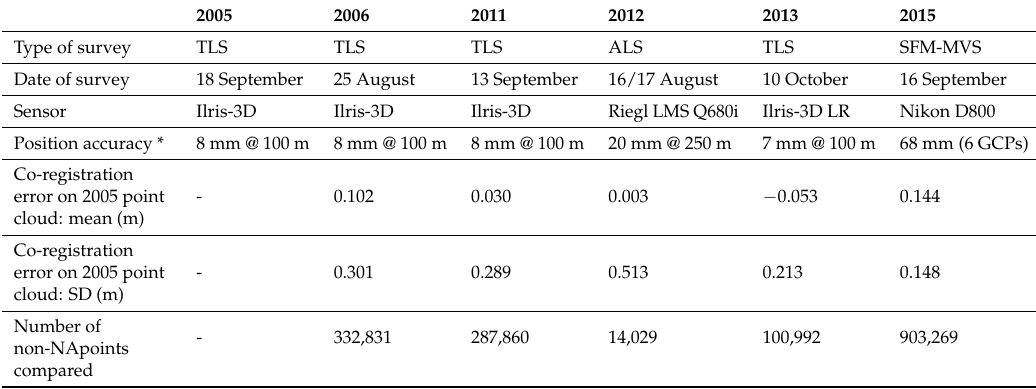
Table 2. Accuracy of the datasets, with absolute values based on the manufacturer factsheet (TLS) or software processing results (SFM-MVS with Agisoft Photoscan), and relative values based on the co-registration error of each DEM on 2005 DEM. * Data according to the manufacturer